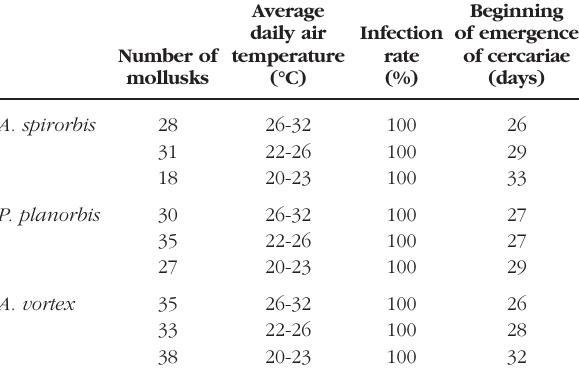
Number of mollusks